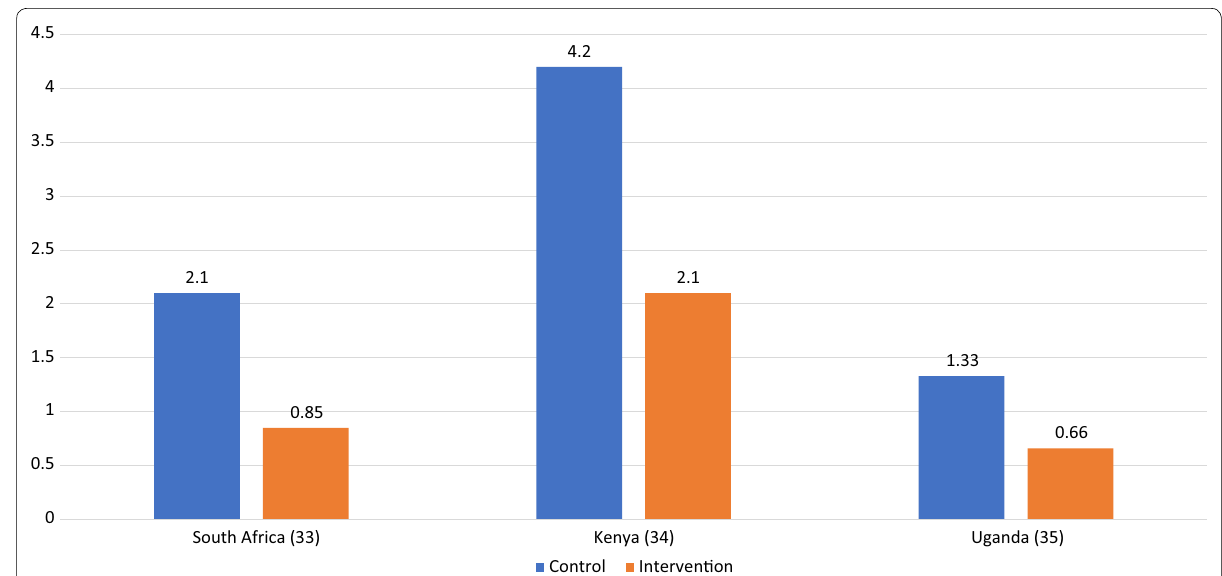
Fig. 1 Comparison of the cumulative HIV incidence (percentage in Kenya and cases per 100 person years in South Africa and Uganda) between control (delayed circumcision) and intervention (immediate circumcision) groups in the three randomized control